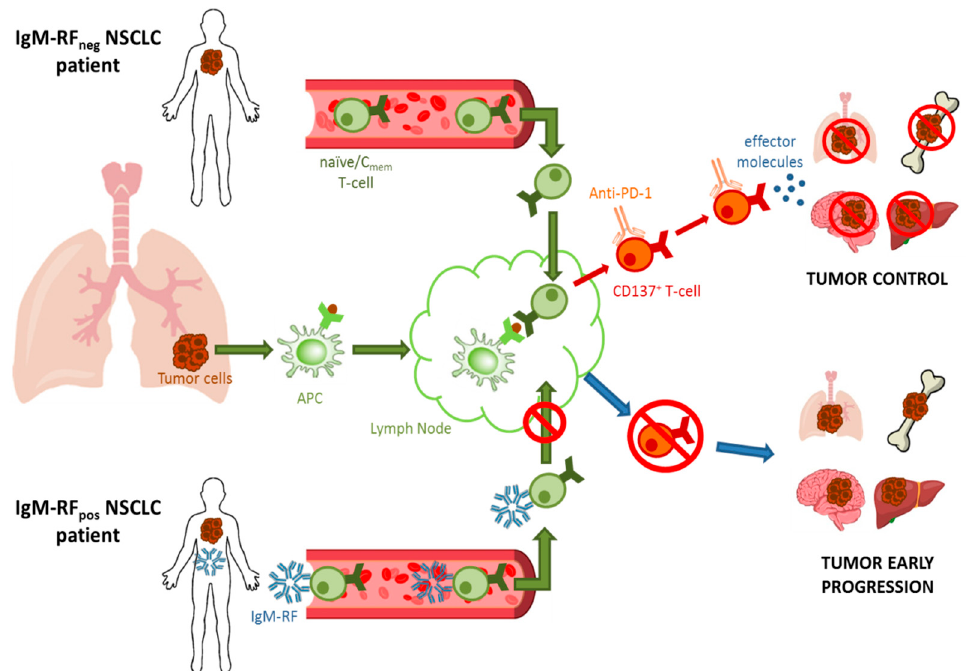
Figure 1. Schematic representation of the suggested effect of immunoglobulin class M (IgM)-rheumatoid factor (RF) in limiting naïve and central memory T-cells recirculation in non-small lung cancer (NSCLC) patients, leading to an impaired CD137 + tumor-directed T-cells expansion and a consequent failure of immune-based immunotherapies.